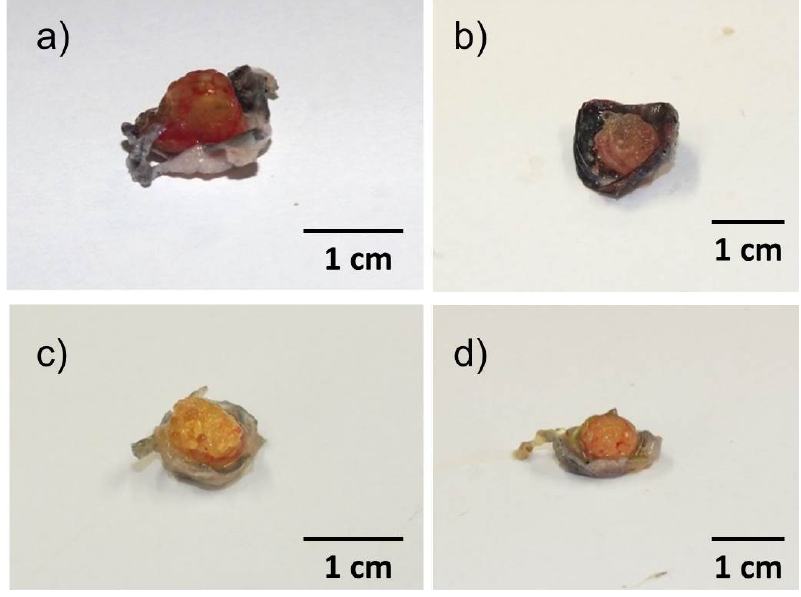
Figure 5. Macroscopic appearance after explantation. ( a ) ADA-GEL, 1 week; ( b ) ADA-GEL-nBG, 1 week; ( c ) ADA-GEL, 4 weeks; ( d ) ADA-GEL-nBG, 4 weeks. Microcapsules were moist and loosely adherent after 1 week ( a , b ) and well adherent, but often dry after 4 weeks ( c , d